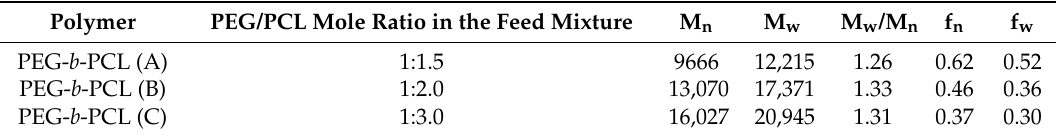
Table 1. Number-average molecular weight, M n , polydispersity index, M w /M n (M w is a weight-average molecular weight), and hydrophilic fraction (fraction of hydrophilic block to total polymer) by number- and weight-average molecular weight, respectively, f n and f w , of the synthesized copolymers, as determined by GPC.